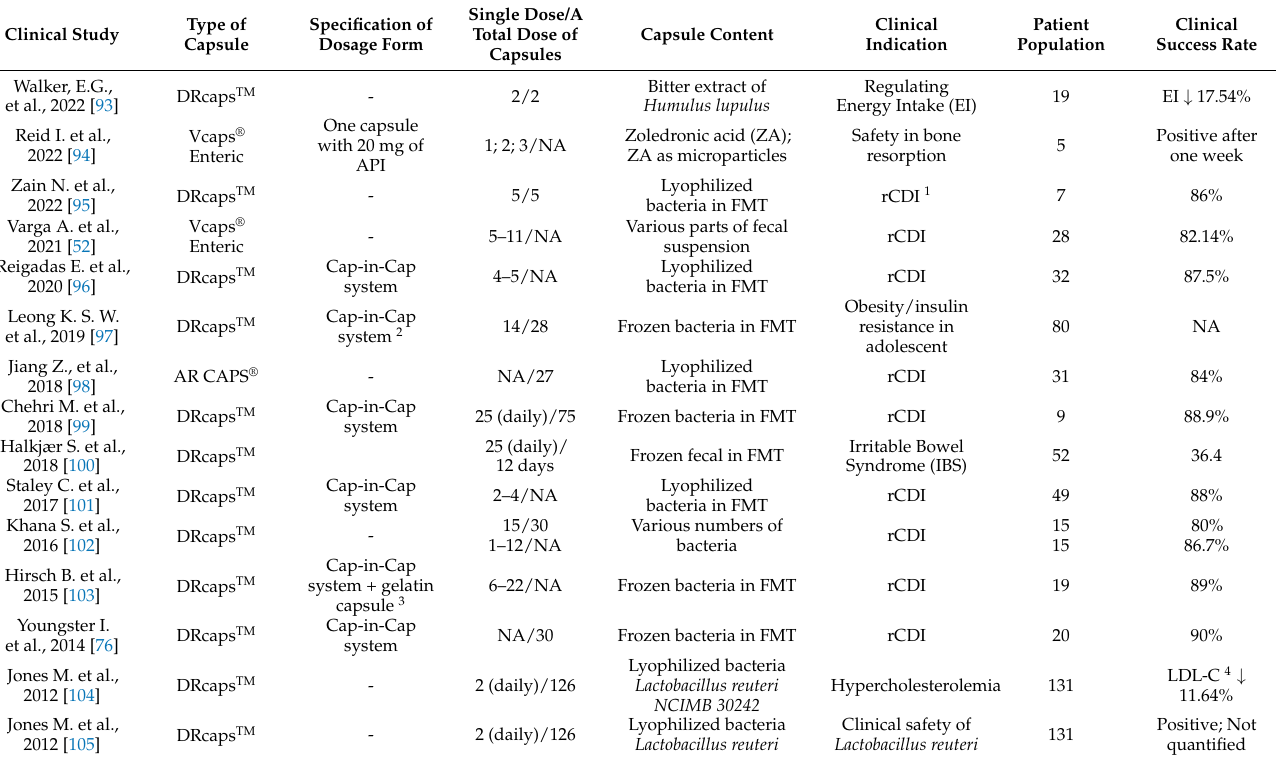
Table 5. Overview of clinical studies with enteric capsules arranged in chronological